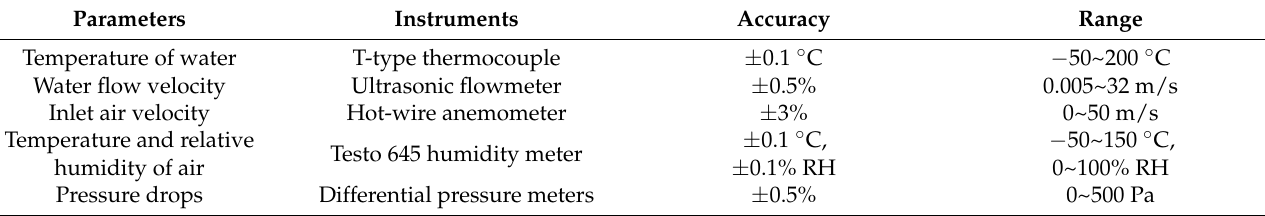
Table 1. Specification of measurement devices.